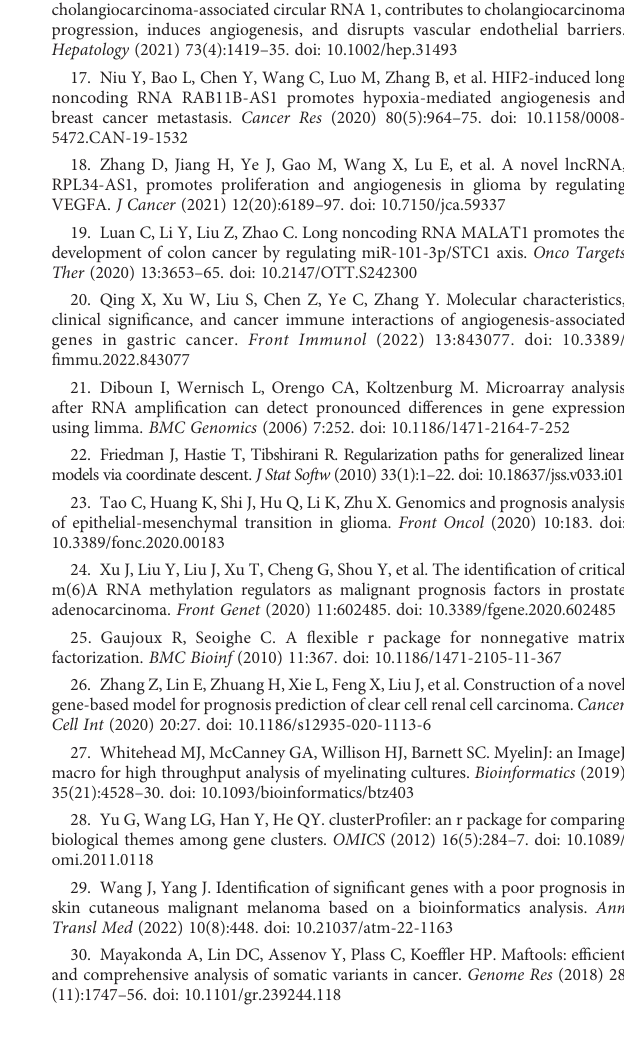
SUPPLEMENTARY FIGURE 4 (A) Summary of variant classi fi cation, variant type, SNV class, and variants per sample in the high-risk group. (B) Summary of variant classi fi cation, variant type, SNV class, and variants per sample in the low-risk